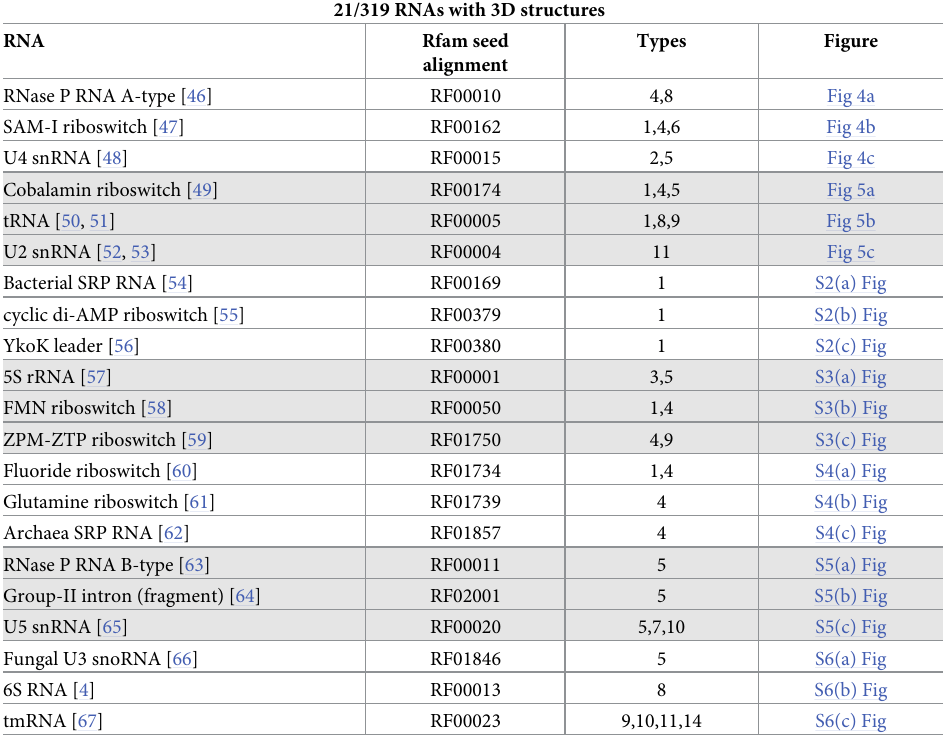
Table 2. 21 RNAs with 3D structures and CaCoFold structures with different covariation support than the struc- tures provided with the structural alignments. Subset of 21/319 CaCoFold structures with more covariation support for which there is 3D structural information (not including the 6 rRNAs). We compare the 21 CaCoFold predicted structures to the 3D structures in Figs 4, 5 and Supplemental S2–S6 Figs. The associated “types” are described in Table 1. 21/319 RNAs with 3D structures